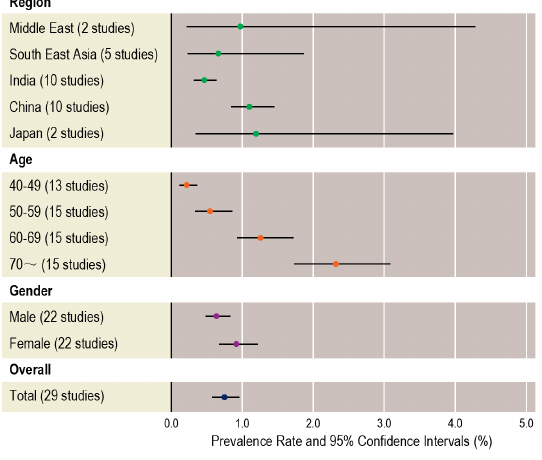
Figure 3. Ethnicity-, age- and gender-specific pooled preva- lence rates of primary angle closure glaucoma.